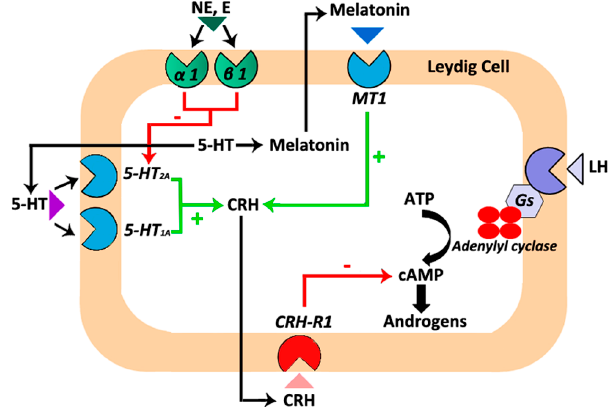
Figure 1. A summary of the interactions between the local melatonergic, serotoninergic, catecholaminergic and corticotropin-releasing hormone (CRH) systems that are involved in the regulation of androgen production in hamster Leydig cells. Melatonin acting through specific melatonergic type 1 (MT1) receptors located in hamster Leydig cells stimulates CRH production [12]. Serotonin (5-HT), the precursor of melatonin, also stimulates CRH production via 5-HT1A and 5-HT2A receptors [38]. Subsequently, CRH through CRH-R1 receptors inhibits human chorionic gonadotropin (hCG)-stimulated androgen production [12,38]. In addition, epinephrine/norepinephrine through α 1/ β 1-adrenergic receptors set up a brake on the inhibitory effect exerted by the 5-HT/5-HT2A receptors/CRH system on androgen production [38]. Green arrows/+ symbolize stimulatory effects. Red arrows/- symbolize inhibitory effects.